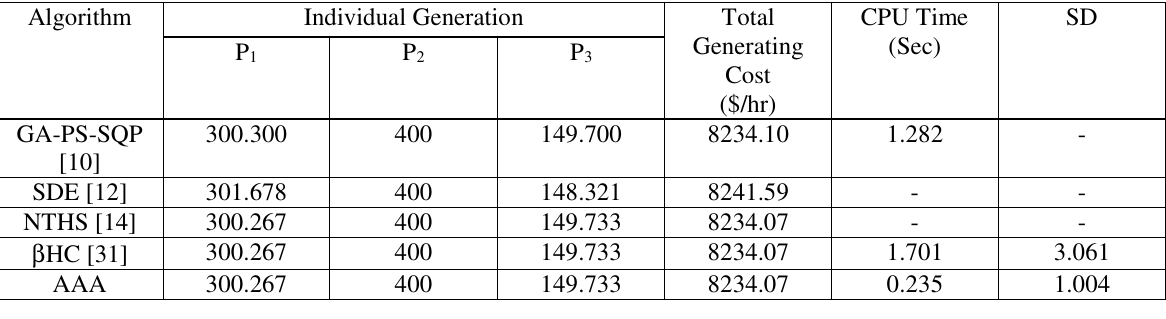
TABLE 1: COMPARISON OF RESULTS FOR TEST CASE